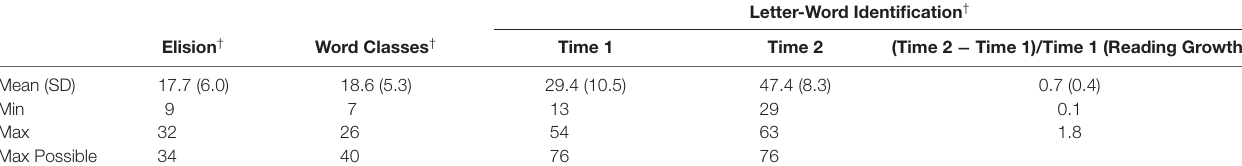
TABLE 2 | Descriptive statistics for the behavioral and fMRI tasks (exploratory